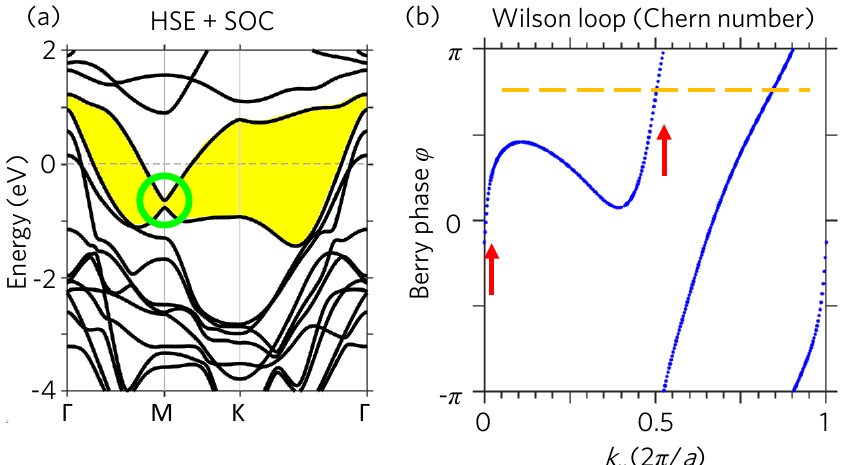
Figure 2. ( a ) HSE+SOC band structure of monolayer 1 T − VSe 2 . The yellow region presents the continuous band gap and the green circle indicates the SOC band gap. ( b ) Wilson loop of monolayer 1 T − VSe 2 with HSE functional and SOC. The red arrows highlight the sharp slope in the Wilson loop. The two crossings through the reference line (the orange dashed line) indicate that the Chern number is two ( C =